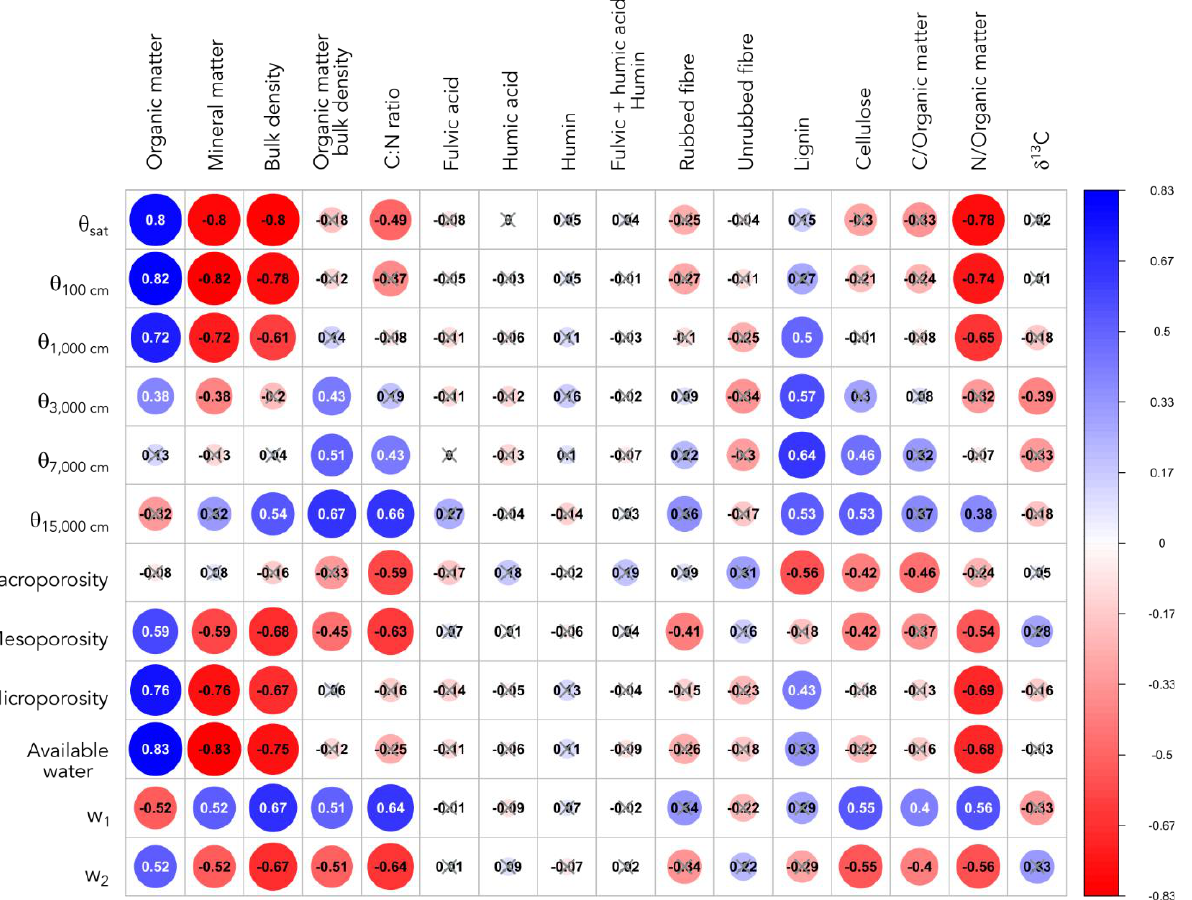
Figure 9. Correlation matrix between water retention and pore size distribution and the soil and organic matter attributes from the studied peatlands. Non-significant correlations are marked ‘ ×